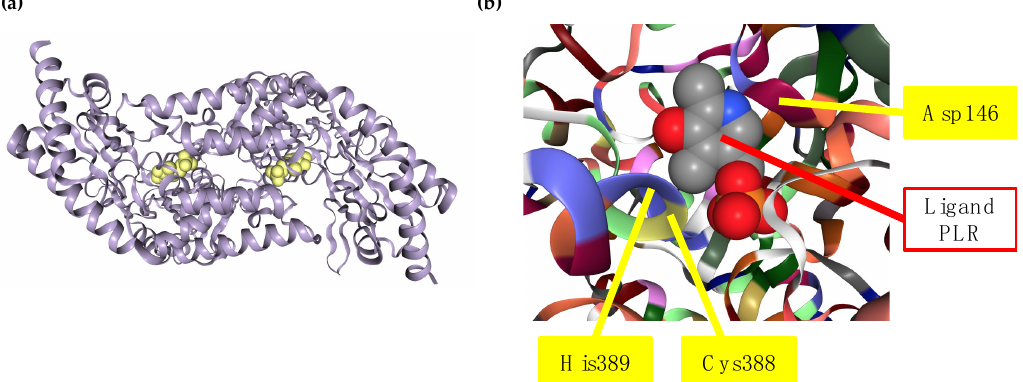
Figure 3. Human SCLY structure. The gray cartoon structure of human SCLY in ( a ) represents the homodimer enzyme with ligand PLR bound (space filled in yellow) to experimentally demonstrate the PLP pocket in SCLY. ( b ) is a close-up view of the active site of human SCLY, with each amino acid residue in one color, and pointing with the yellow bars to critical residues Cys388 (yellow), His389 (purple), and Asp146 (chianti). Space filled ligand, PLR, is shown in gray, red, and blue. The human SCLY structure was obtained from the Protein Data Bank (PDB) Japan entry number 3GZC, deposited by Collins et al. [41], and using the Research Collaboratory for Structural Bioinformatics (RSCB) PDB online tool (rscb.org)